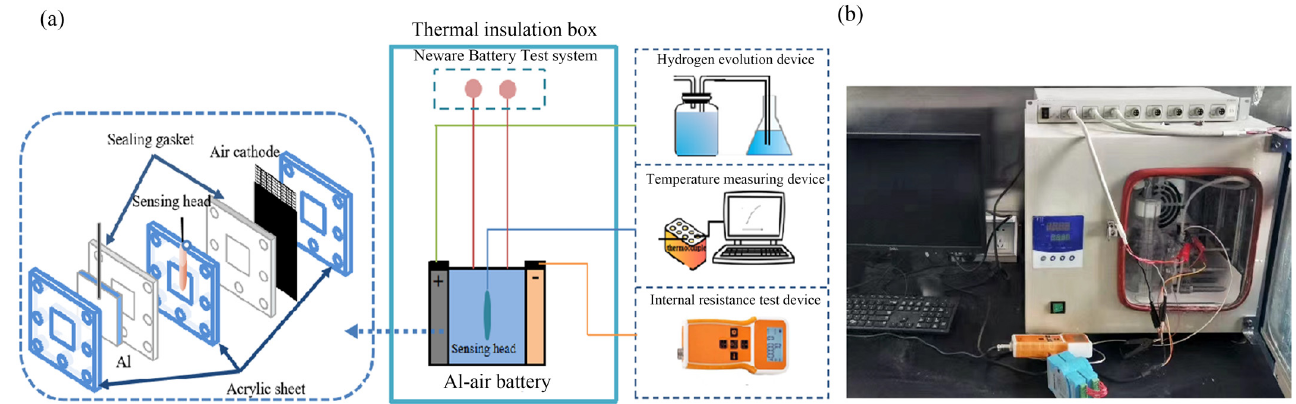
Figure 2. Schematic diagram ( a ) and optical photo ( b ) of the aluminum − air battery structure and thermal effect test system.